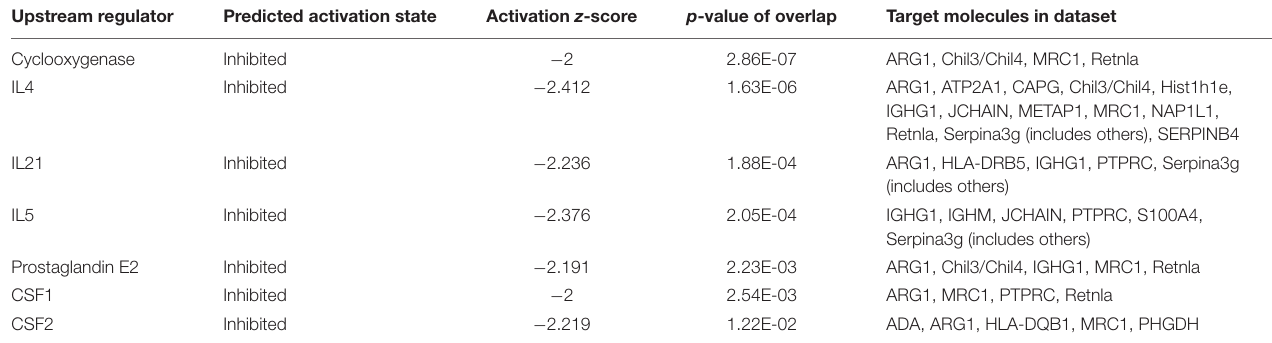
TABLE 6 | Upstream analysis of CON vs. the MOD group. Upstream regulator Predicted activation state Activation z -score p -value of overlap Target molecules in